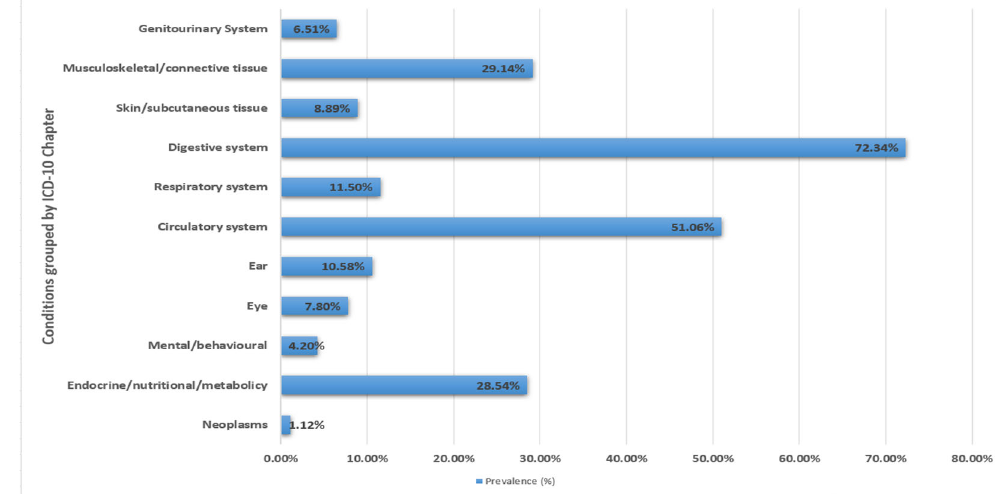
Figure 2. Prevalence of chronic conditions grouped by ICD ‐ 10 chapters. Table 3. Prevalence Risk Ratio (PRR) and Prevalence Risk Differences (PRD) and Adjusted Prevalence Risk Ratio (APRR) and Adjusted Prevalence Risk Differences (APRD) of complex multimorbidity across various socio-demographic